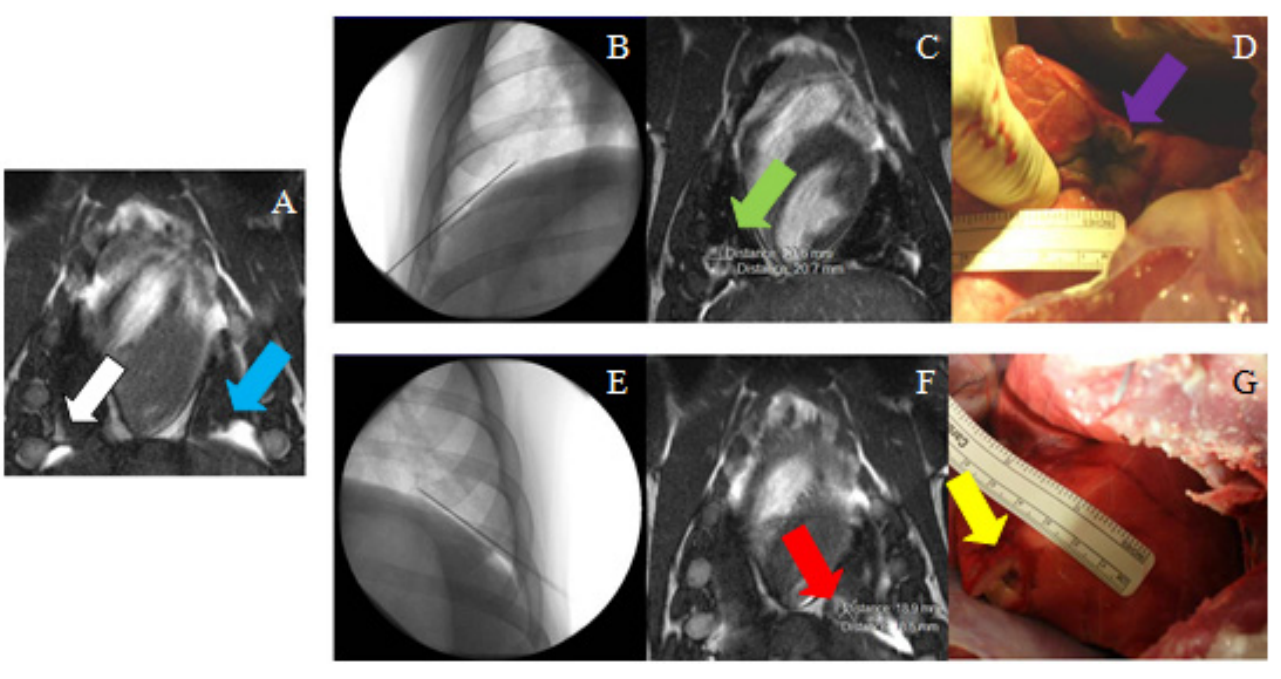
Figure 5. ( A ) MR image (True FISP) used for treatment planning in the right (white arrow) and the left (blue arrow) sides for pig #4. ( B ) Needle placement in the right side (fluoroscopy image); ( C ) post-ablation MRI (True FISP), showing the ablated area in the right side (green arrow); ( D ) necropsy image showing the ablated area in the right diaphragm (purple arrow). ( E ) needle placement in the left side (fluoroscopy image); ( F ) post-ablation MRI (True FISP), showing the ablated area in the left side (red arrow); ( G ) necropsy image showing the ablated area in the left diaphragm (yellow arrow).